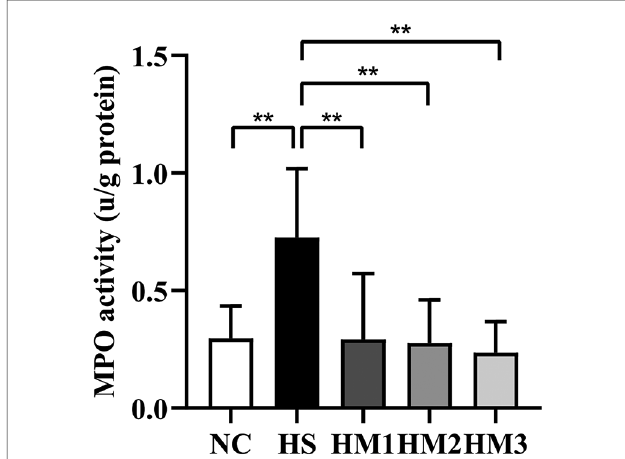
FIGURE 5 Human umbilical cord-derived mesenchymal stem cells (hUC-MSCs) reduces myeloperoxidase (MPO) activity of the lung tissue. The rat pups reared in the HS group yielded signi fi cantly higher MPO activity than did those reared in the NC group. hUC-MSCs (1×10 6 cells, 5×10 6 cells, or 1×10 7 cells) reduced the hyperoxia-induced MPO activity increase. ** P <0.01. Data was presented as means±SEM, n =6 – 8 per